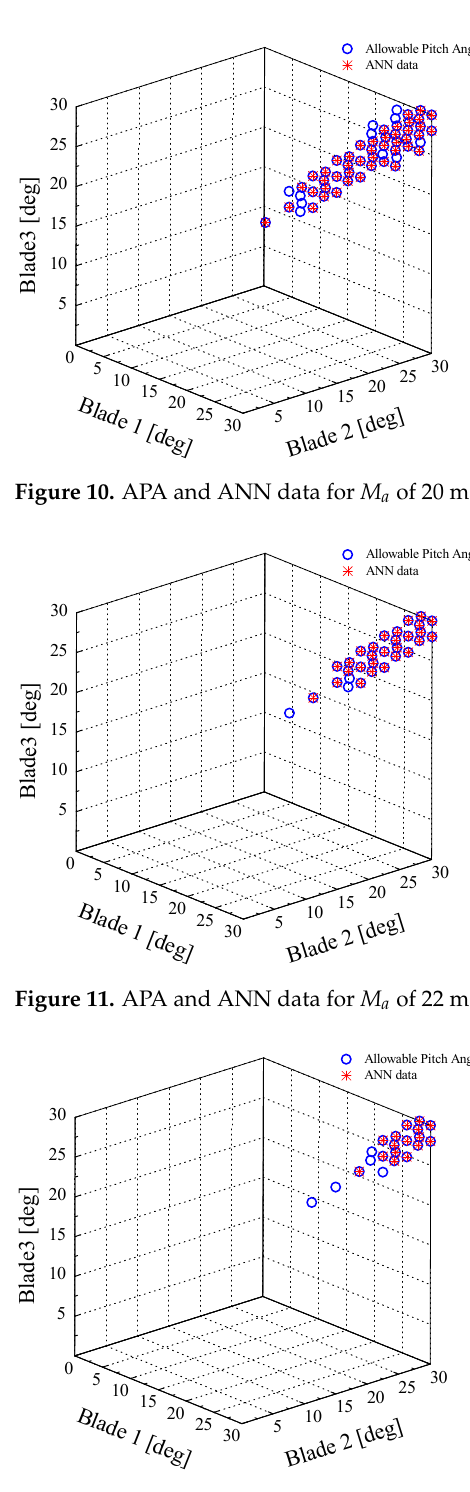
Figure 12. APA and ANN data for M a of 24 m/s.